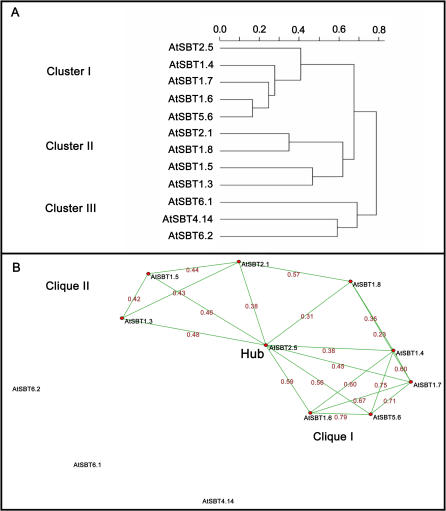
Transcript-Level Correlations of Ubiquitously Expressed Subtilase Genes in Multi-Conditional 22k Affymetrix Expression Profiles(A) shows a cluster tree of the of the transcript level correlations of ubiquitously expressed subtilase genes in multi-conditional 22k Affymetrix expression profiles. Correlations were determined by computing the Spearman's rank order correlation. (B) shows a network of all significantly positive associated AtSBTs according to the average Spearman correlation.